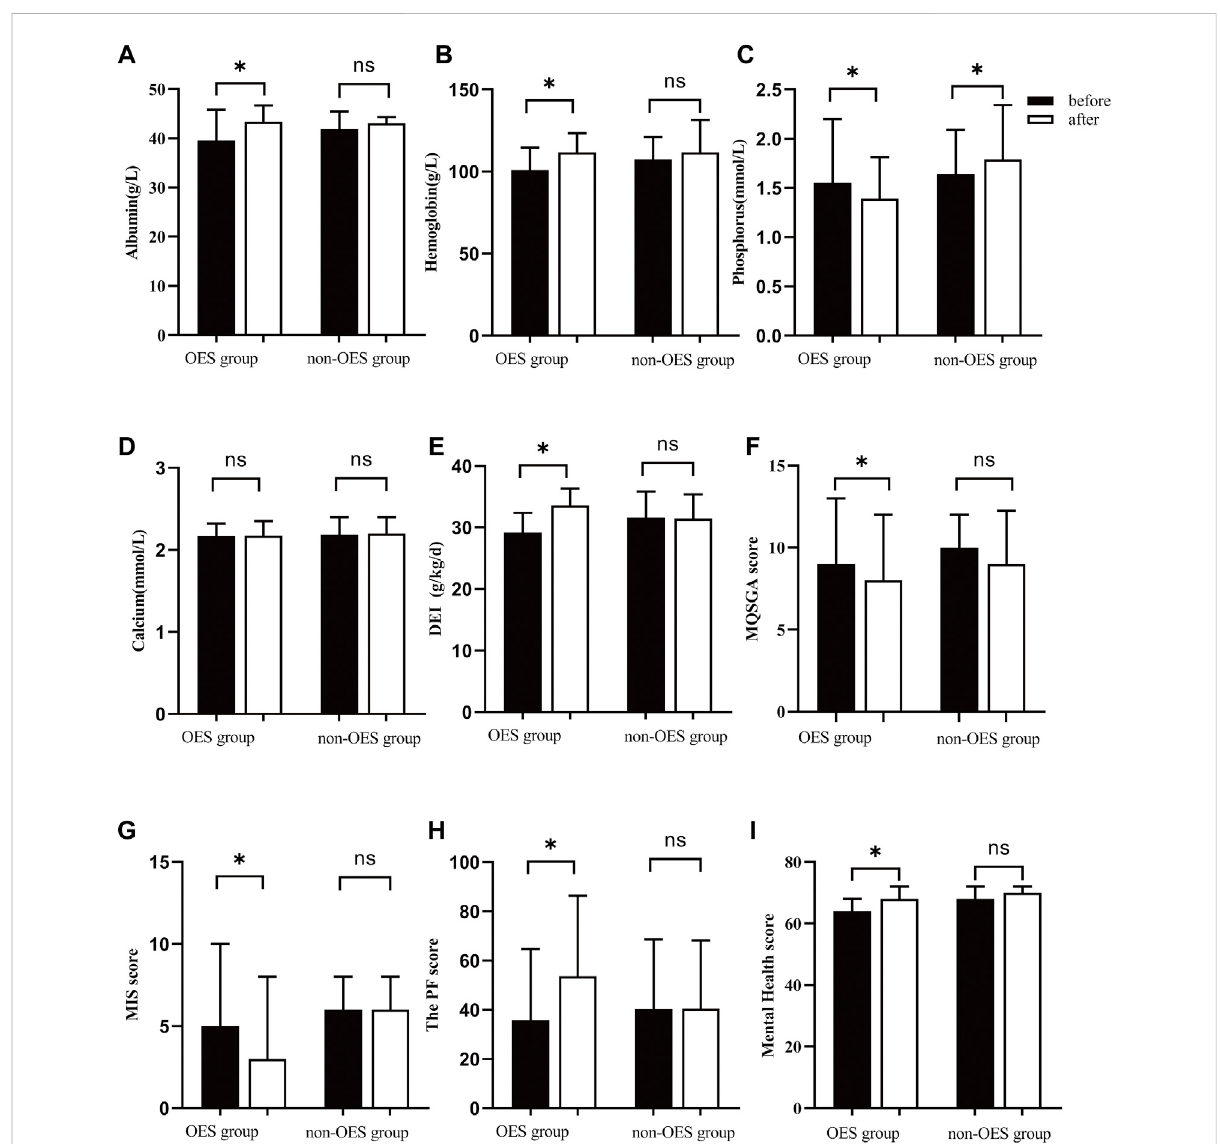
FIGURE 2 Mean/medianchangesintotalAlb (A) , Hb (B) , P (C) ,Ca (D) ,DEI (E) ,MQSGA (F) ,MIS (G) ,and SF36 (H,I) after nutritional intervention. *represents p <